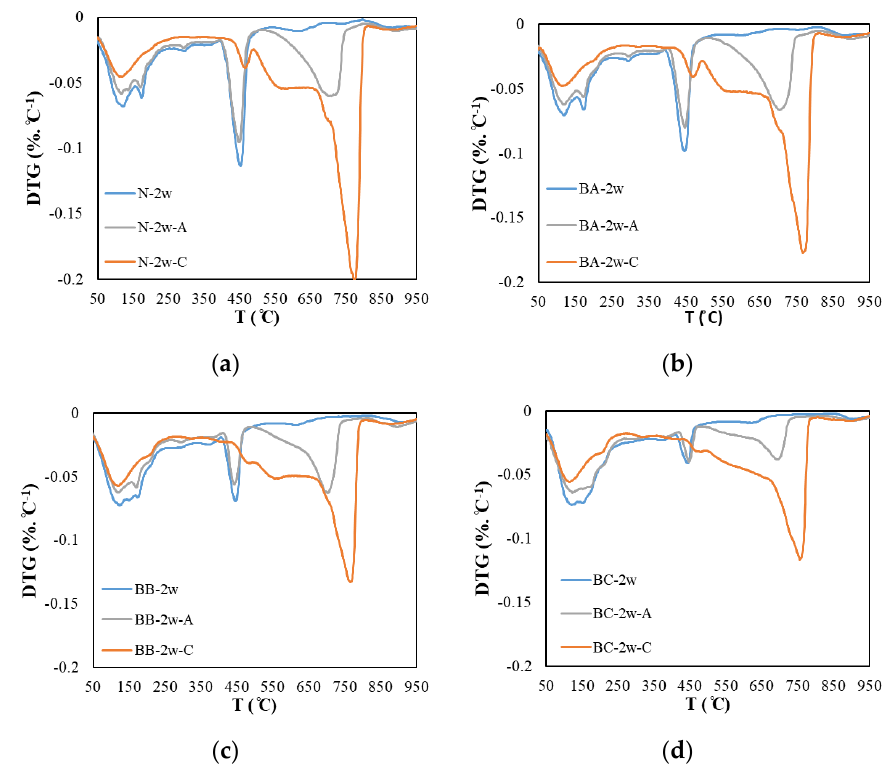
Figure 3. Mass loss of carbonated cement paste. ( a ) N; ( b ) BA; ( c ) BB and ( d ) BC.